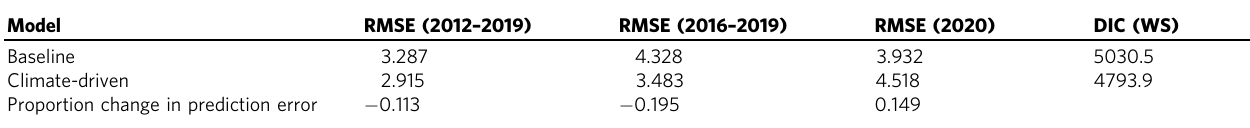
Table 1 Retrospective and prospective predictive accuracy of climate-driven Lassa fever incidence